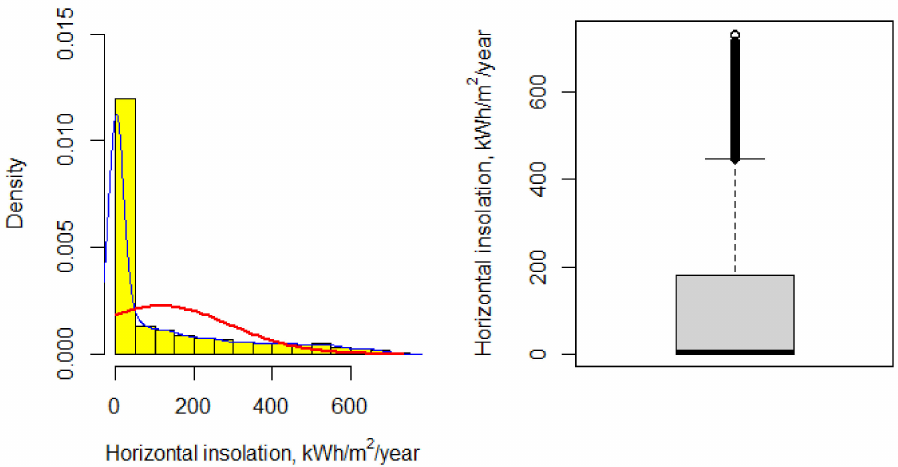
Figure 12. The graphical representation of the distribution of hourly insolation in the horizontal location of objects M1, M2 and M3. Source: own study in RStudio environment based on ERA5- Land data.